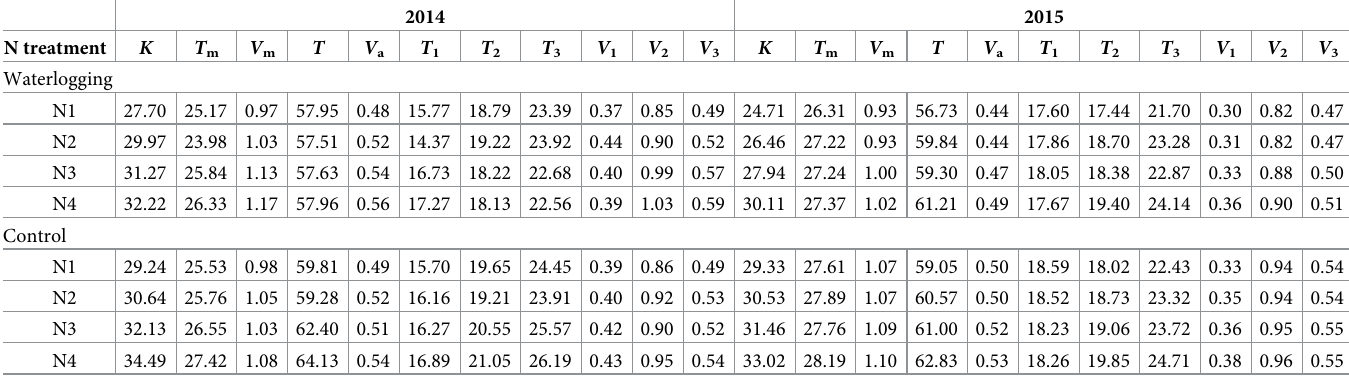
Table 5. Effects of different nitrogen treatments on grain filling characteristics parameters under waterlogging in the seedling stage.